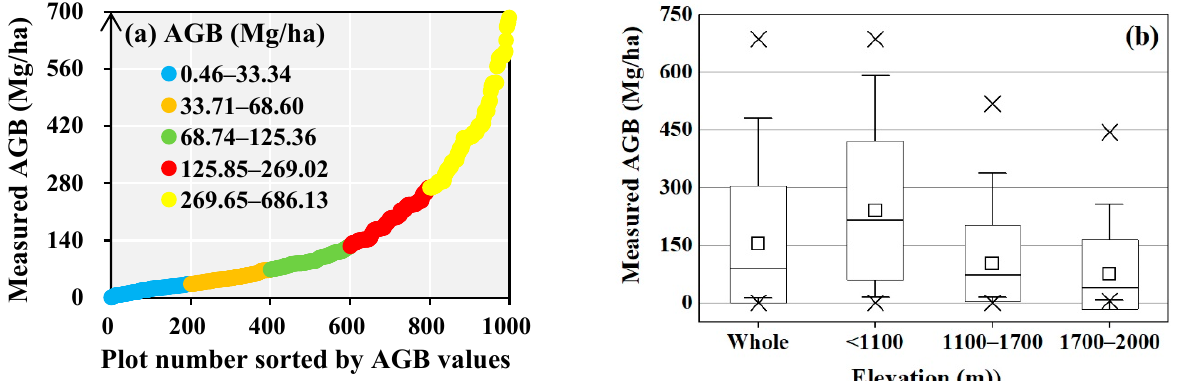
Figure 6. The AGB profiles of forest measured samples from Plot 1 to 1000 ( a ) and value distribution along different altitudinal gradients ( b ). The boxes denote values within the range of the mean ± standard deviation (SD), lines in boxes are medians, and squares depict means with the dash as the whisker of 5–95%, as well as crosses as the minimum and maximum values.